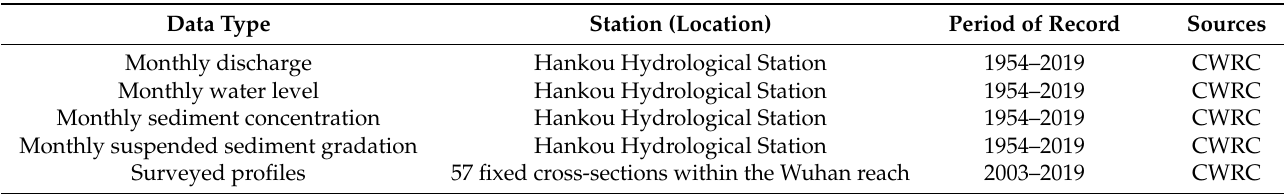
Table 2. Sources of